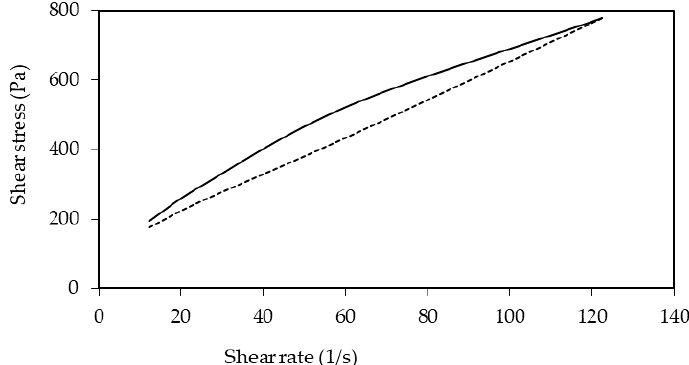
Figure 5. Flow curve of the QSB-based emulsion (line—up curve; dot—down curve).